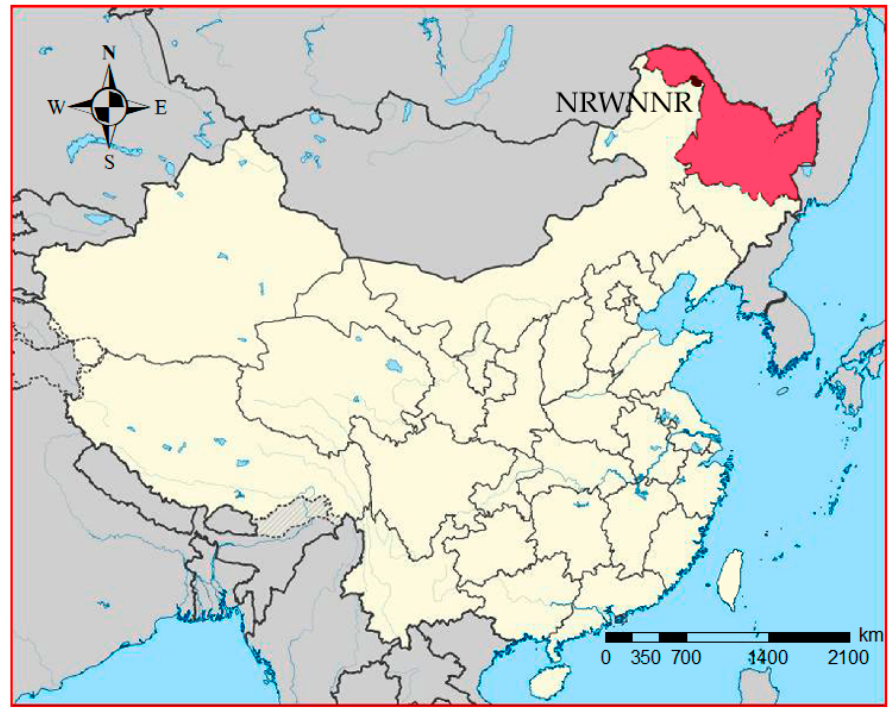
Figure 6. Map of the study area of NRWNNR in northeast China. Heilongjiang province in deep color, NRWNNR in the deepest color.